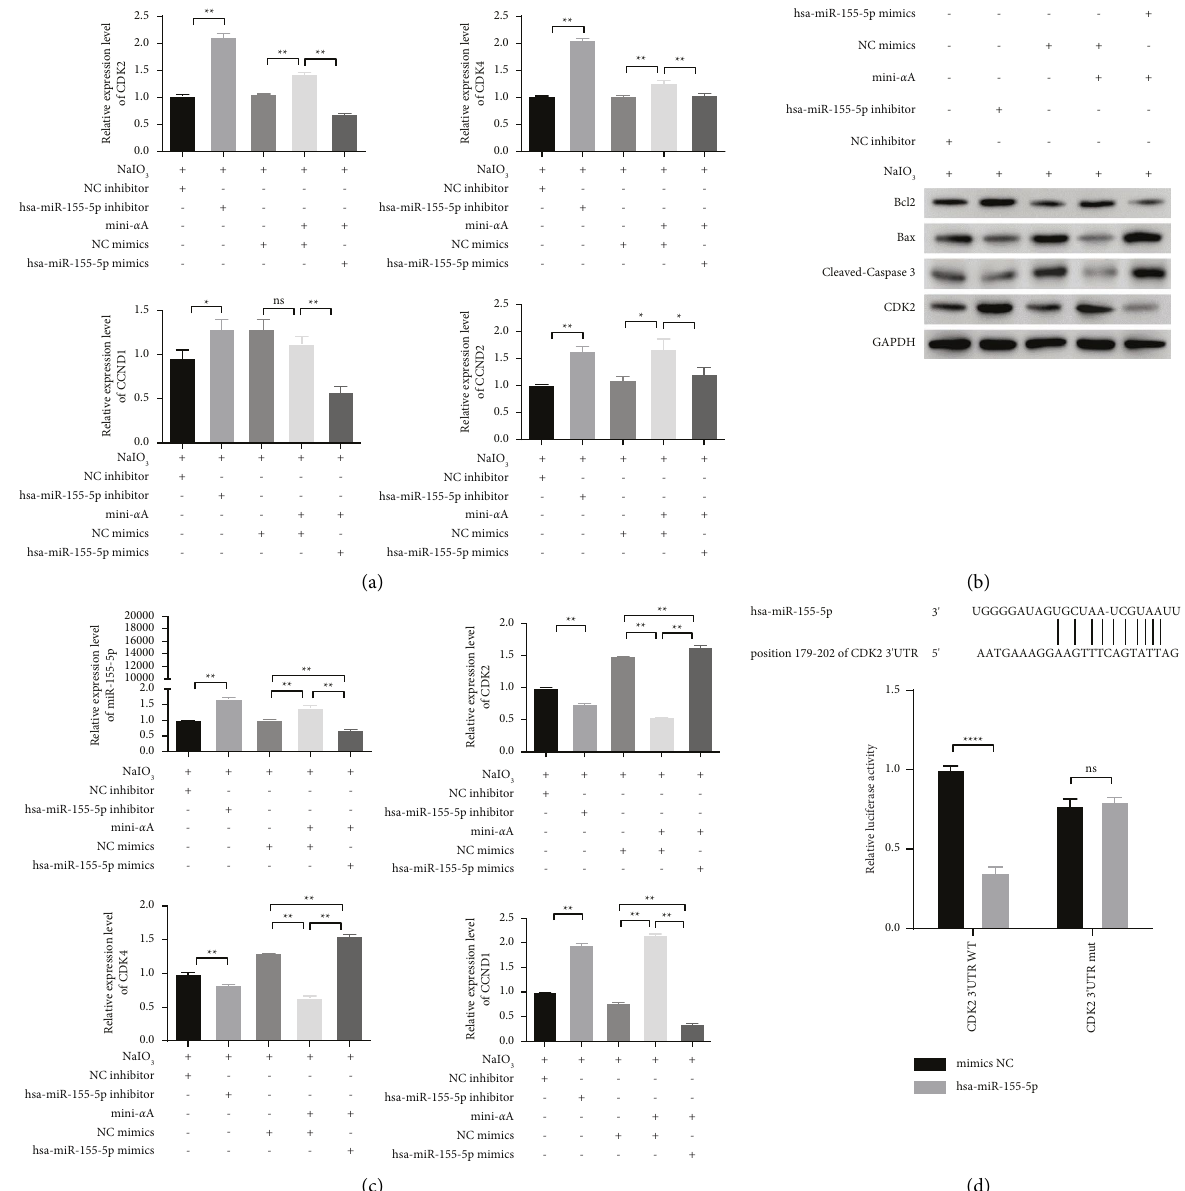
Figure 4: miR-155-5p participates in the therapeutic efects of mini- α A by regulating CDK2. ARPE-19 cells were treated with NaIO following which interference and overexpression of miR-155-5p were performed. (a) Four target genes related to the cell cycle predicted by miRanda were detected by qRT-PCR. (b) Te expression of Bcl2, Bax, cleaved caspase-3, and CDK2 was measured by western blotting. (c) Densitometric quantitation of proteins is probed in Figure 4(b). (d) Te binding site between 3 ′ UTR of CDK2 and miR-155-5p was predicted by miRanda, and dual-luciferase reporter assay was performed to detect the luciferase activity in wild-type (WT) and mutant (mut) of 293T cells after transfection with NC mimics and miR-155-5p mimics. ns, not signifcant; ∗ P < 0 . 05 and ∗∗ P < 0 .